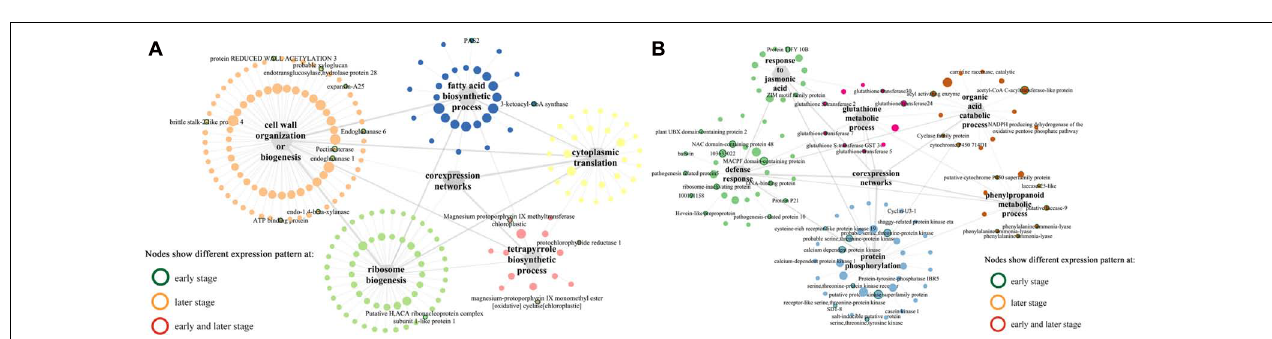
FIGURE 5 | Co-expression networks of top 5 GO terms (biological process) constructed by WGCNA. (A) Turquoise module. (B) Blue module. The gray hexagons represent gene groups enriched in corresponding GO terms, and the gray lines linked with hexagons represent the connectivity between genes in corresponding GO term; the wider the line, the higher connectivity the genes. The node with colored border indicates different expression pattern at either early or later or both infection stages between susceptible and resistant lines.